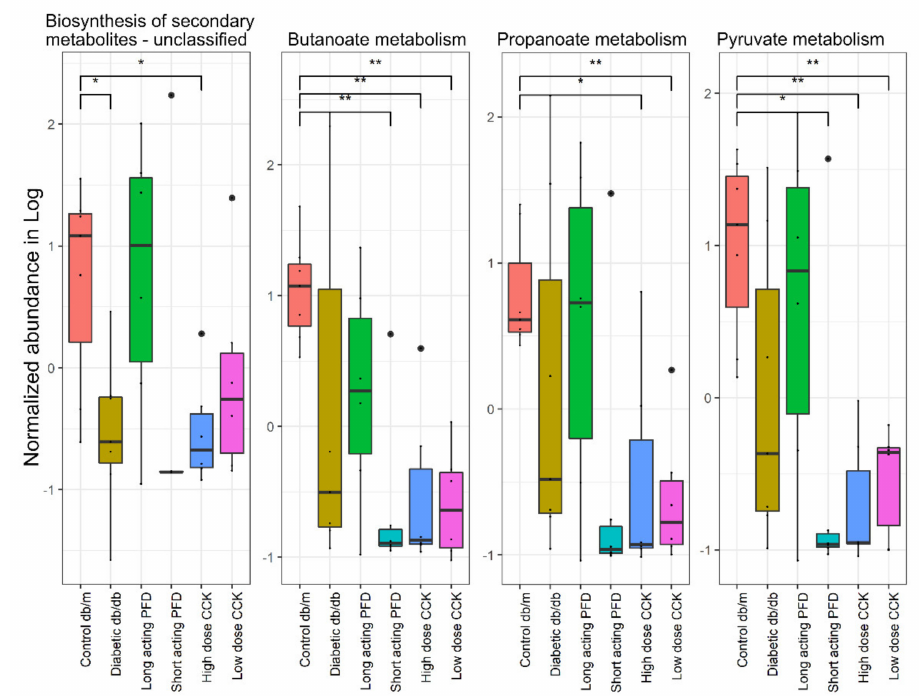
Figure 8. The molecular functions were predicted using the Piphillin web server. Their relative abundance in control db / m, diabetic db / db and the four treatment groups. Significance levels between two groups is indicated by stars (* = 0.01 to 0.05, ** = > 0.001 to 0.01) and no comparison / stars mean no statistical significance was found between